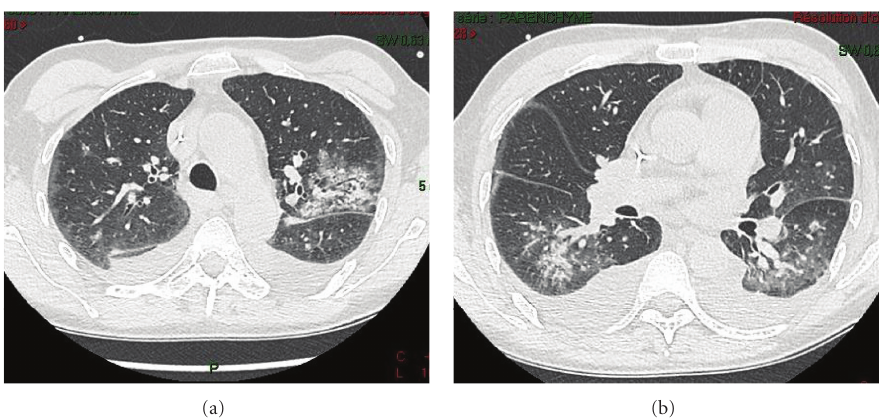
Figure 1: Thoracic computed tomography scan of the patient, showing bilateral and di ff use extension of the infection. (a) Bilateral subpleural and peribronchial infiltrates with bilateral pleural e ff usion in the superior lobes. (b) Disseminated alveolointerstitial infiltrates in the basal